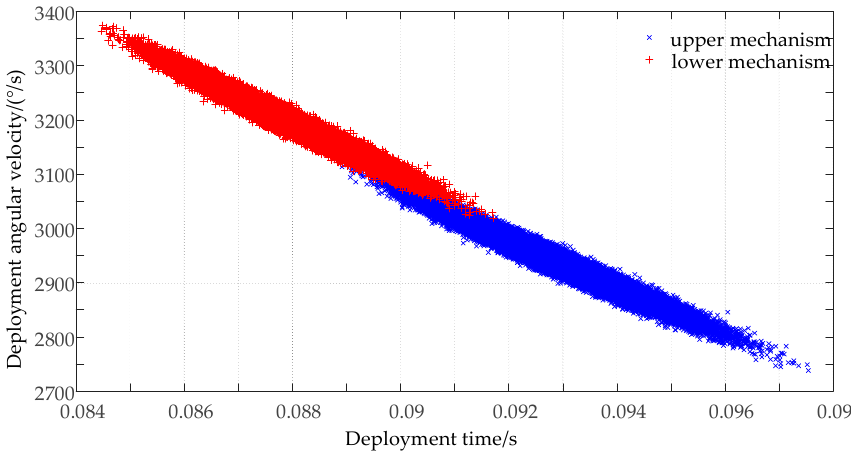
Figure 11. Data graph for deployment time and angular velocity in specified position. The results show that the deployment time in the specified position of the upper mechanism is greater, despite its deployment angular velocity in the specified position being smaller than the lower mechanism. Consequently, both deployment performances need to be considered when calculating reliability. As shown in Figure 12, a normal distribution with a confidence level of 0.05 is used to fit the discrete dots of the deployment angular velocity of the mechanism, and the kstest method is used to examine the normality. Among them, the red lines represent the lower mechanism while the blue lines represent the upper mechanism.